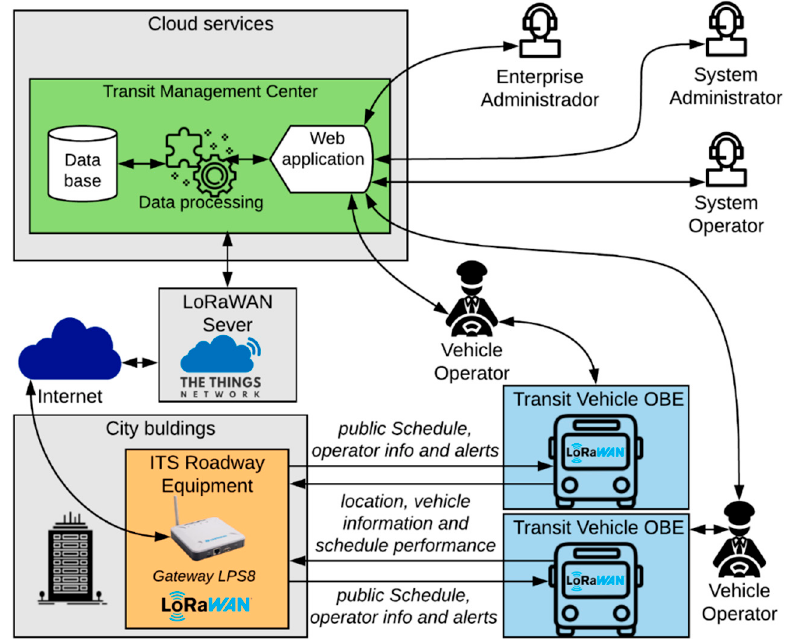
Figure 4. Network diagram for the proposed FMCS prototype.